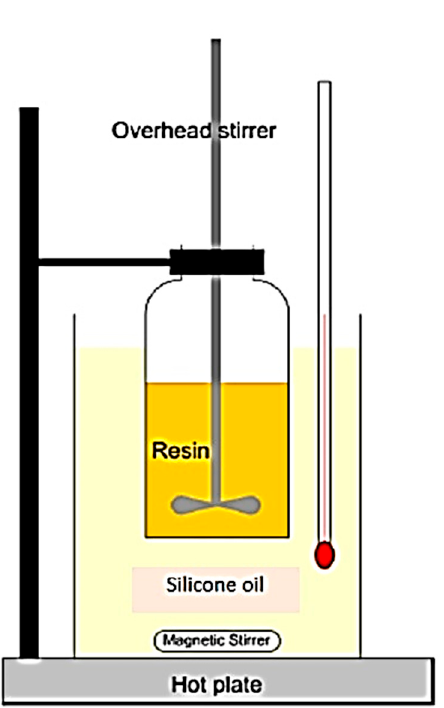
Figure 5. Epoxy blending setup.